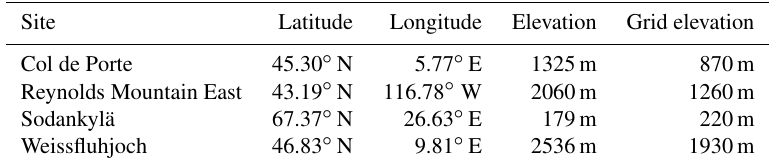
Table 1. Site locations and 0.5 ◦ grid